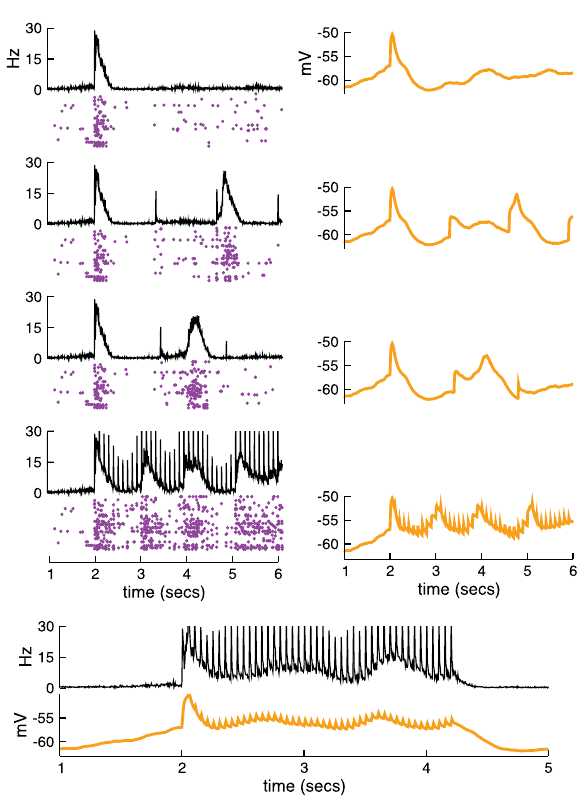
Figure 10. The effect of stimulation frequency on the generation of up states . In the top row, a single pulse has been applied. In the following rows, from top to bottom, the stimulus has frequencies of 0.77, 0.71, 10 and, in the bottom panels, 20Hz. Each of the top four rows contains the population rate and the rastergram (left column) and the average membrane potential (right column). At the bottom, the population rate and average membrane potential are stack to allow for a greater time resolution. In the second row, the second pulse at 0.77Hz fails to generate an up state. In the third row, the second pulse at 0.71Hz succeeds in evoking an up state. Comparison of these traces with those obtained at 0.5Hz in Figure 9 shows that the activity propagates more slowly (the second peak in the population rate occurs after a longer time). For stimulation at 10Hz and above (fourth row and bottom), the membrane remains depolarized during all of the stimulation time.